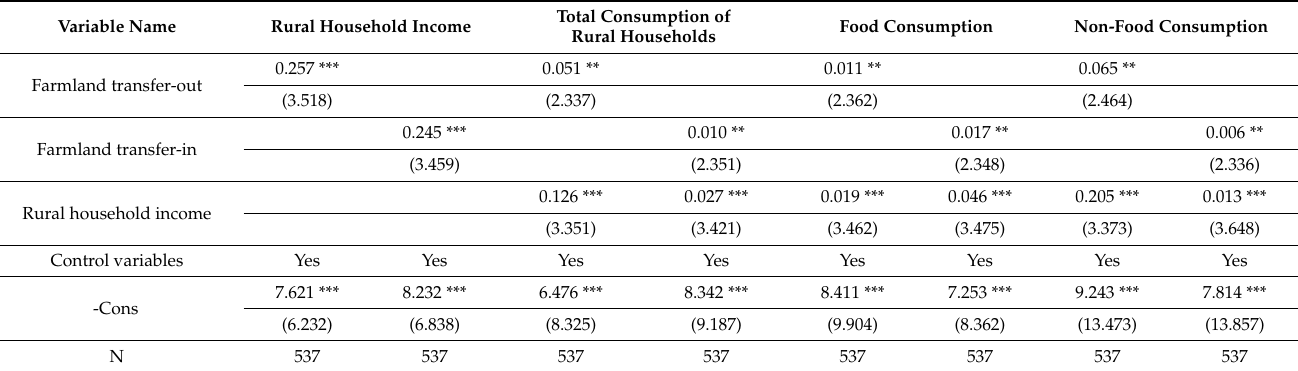
Table 8. Intermediary effect test.